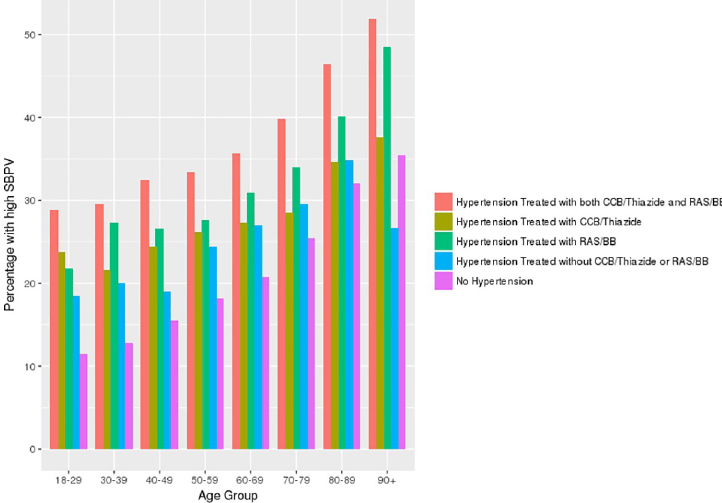
Fig 3. Frequency of high blood pressure variability in adults, subdivided by age, hypertension status, and drug treatment.